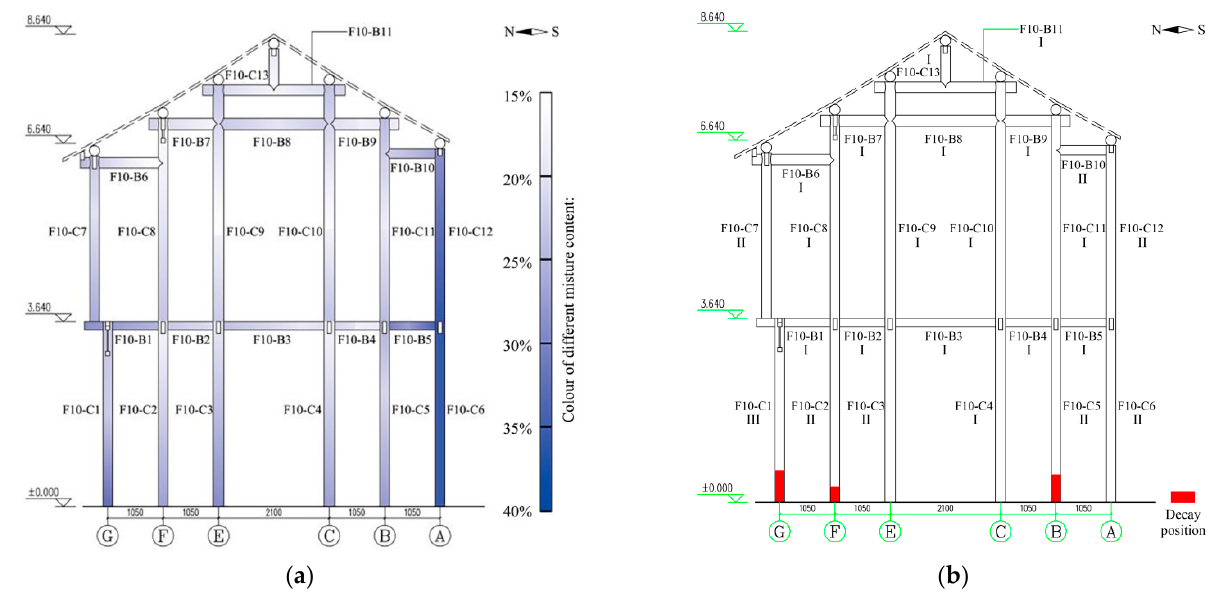
Figure 21. Moisture content and decay of F10 in Fujiu Zhou house; ( a ) schematic diagram of moisture content; ( b ) schematic diagram of decay position and decay grade.